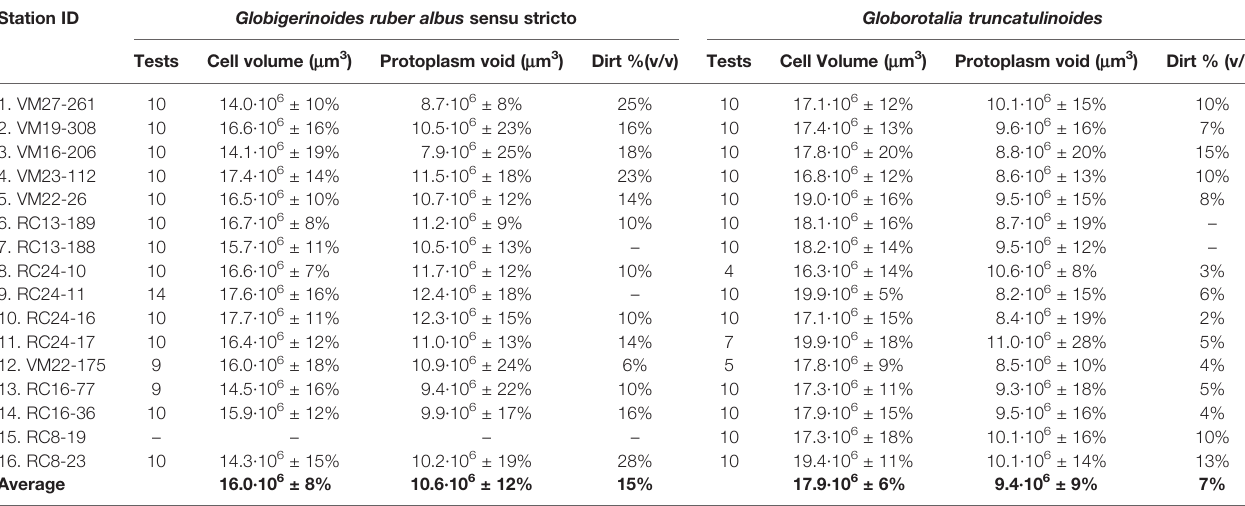
TABLE 2 | Table of volumetric data from the spatial analysis of the tomographic images of the two different scanned species. Station